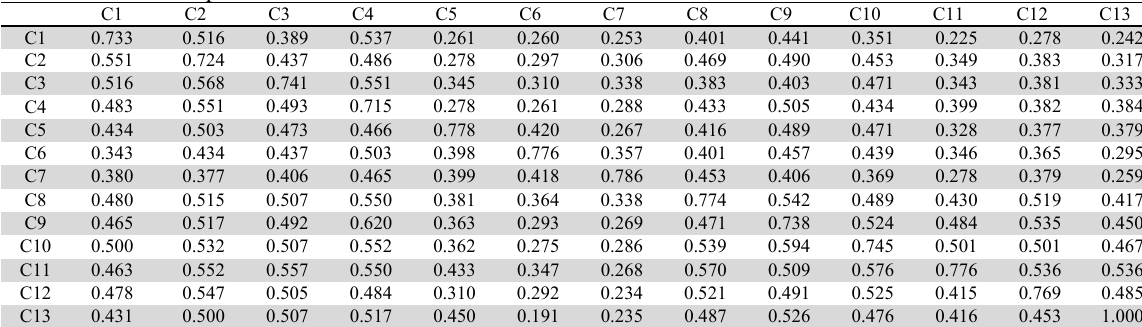
Initial interrelationship matrix of criteria